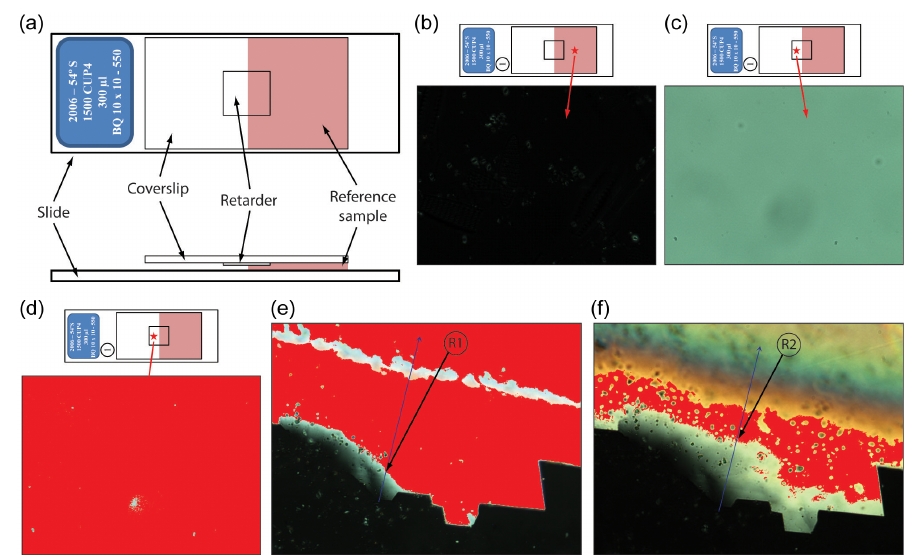
Figure 2. Technique for validating wedge thickness at two tie points. (a) Distribute a retarder polymer and reference sample on a slide. Only half of the retarder is covered by the reference sample. (b) Focus the coccoliths of the reference sample, (c) move to the sample-free part on the retarder polymer, and (d) increase the light intensity until polymer saturation (the image acquisition software indicates the saturated area in red). (e–f) Wedge calcite saturated under the same conditions as the retarders 1 and 2, respectively. The arrows (R1, R2) indicate the points where the thickness has been